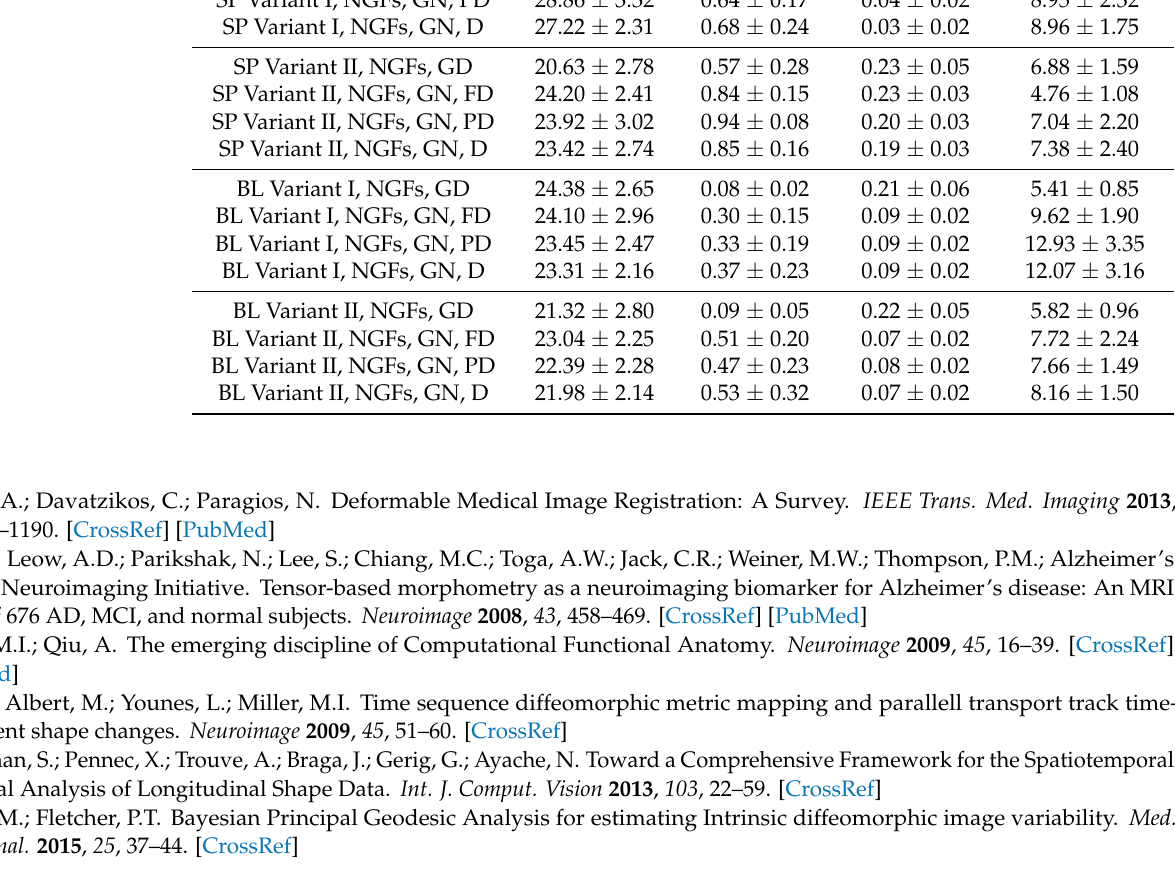
Table A2. NIREP16. Convergence results. Mean and standard deviation of the relative image similarity error expressed in % ( MSE rel ), the relative gradient magnitude ( determinant extrema associated with the transformation ( φ v